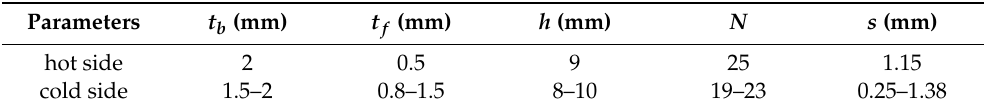
Table 2. Parameter settings of heat